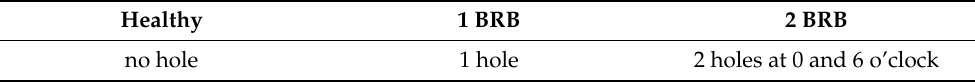
Figure 9. ( a ) On the left, 1 BRB: rotor with one hole. ( b ) On the right, 2 BRB: rotor with two holes. Table 3. Broken rotor bar